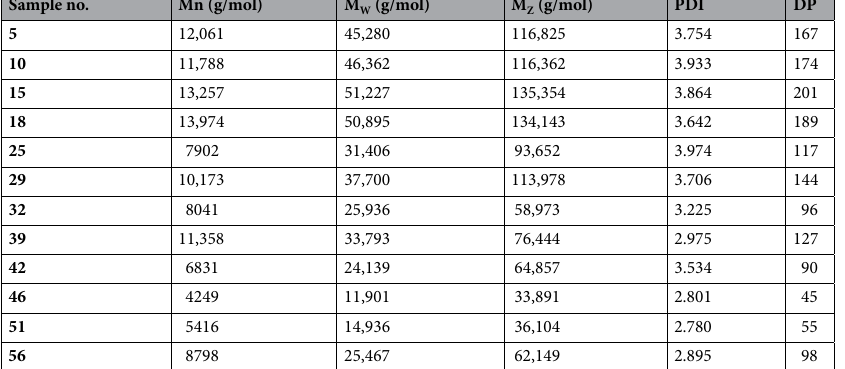
Table 2. GPC analysis of selected samples of cellulose acetate prepared using different amount of ferric perchlorate catalyst and different amount of acetic anhydride. The DP calculated values were calculated and normalized depending on the DS as previously reported 7,8 . Mn number average molecular weight,